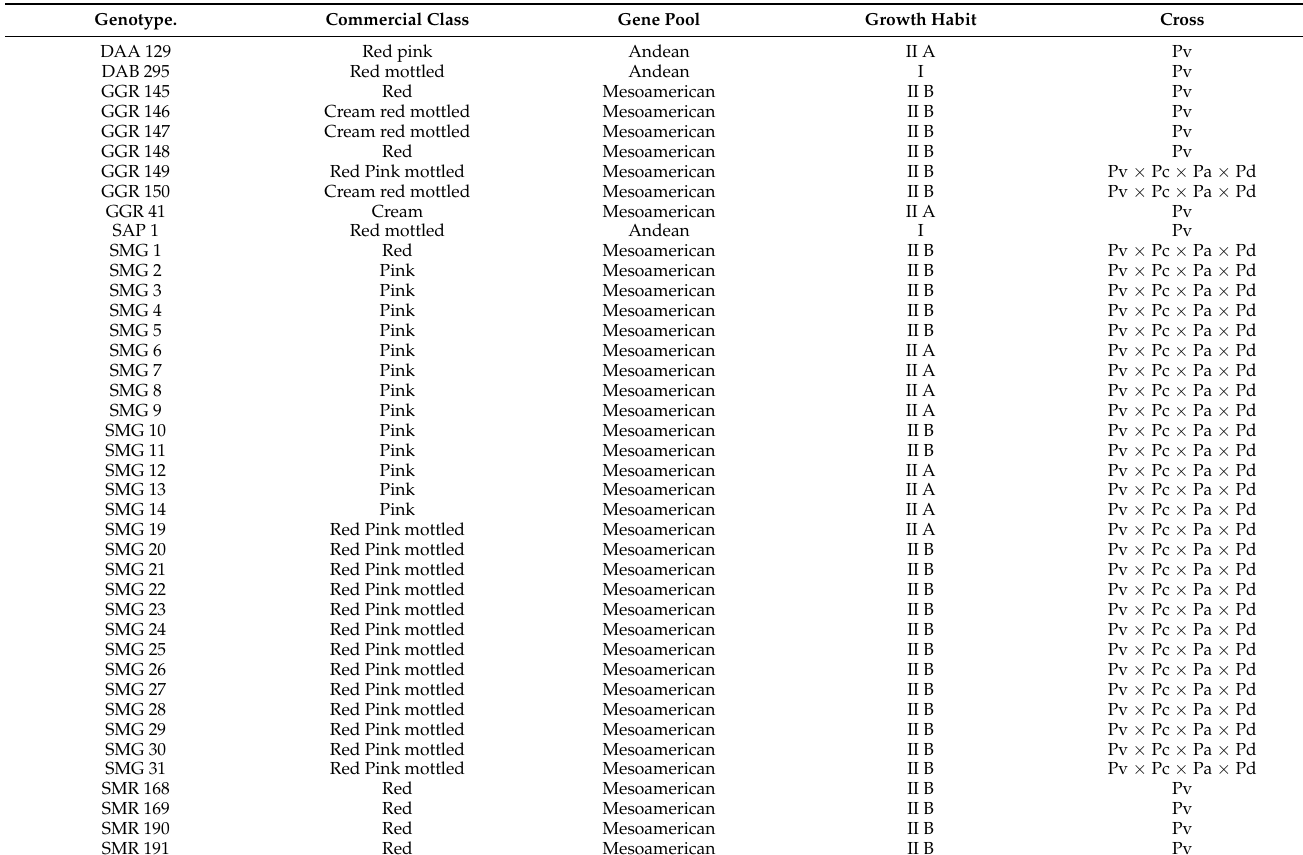
Table 3. List of interspecific Mesoamerican common bean lines to acid soils and high temperature stress at the Macagual Research Center of the University of Amazonia during two seasons (2019, 2020).